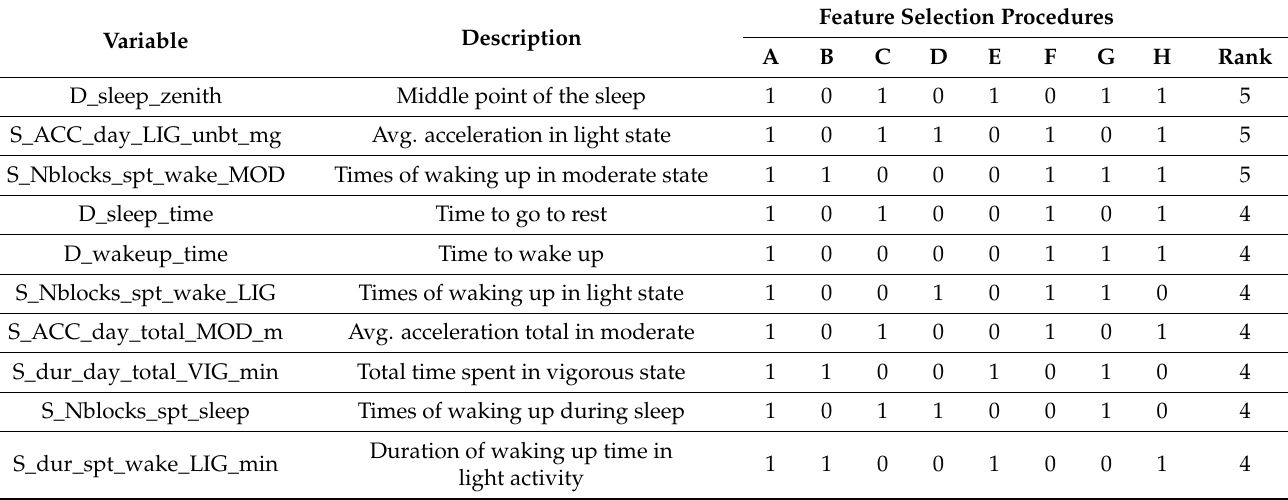
Table 3. Selected variables by the Feature Selection methods for patient